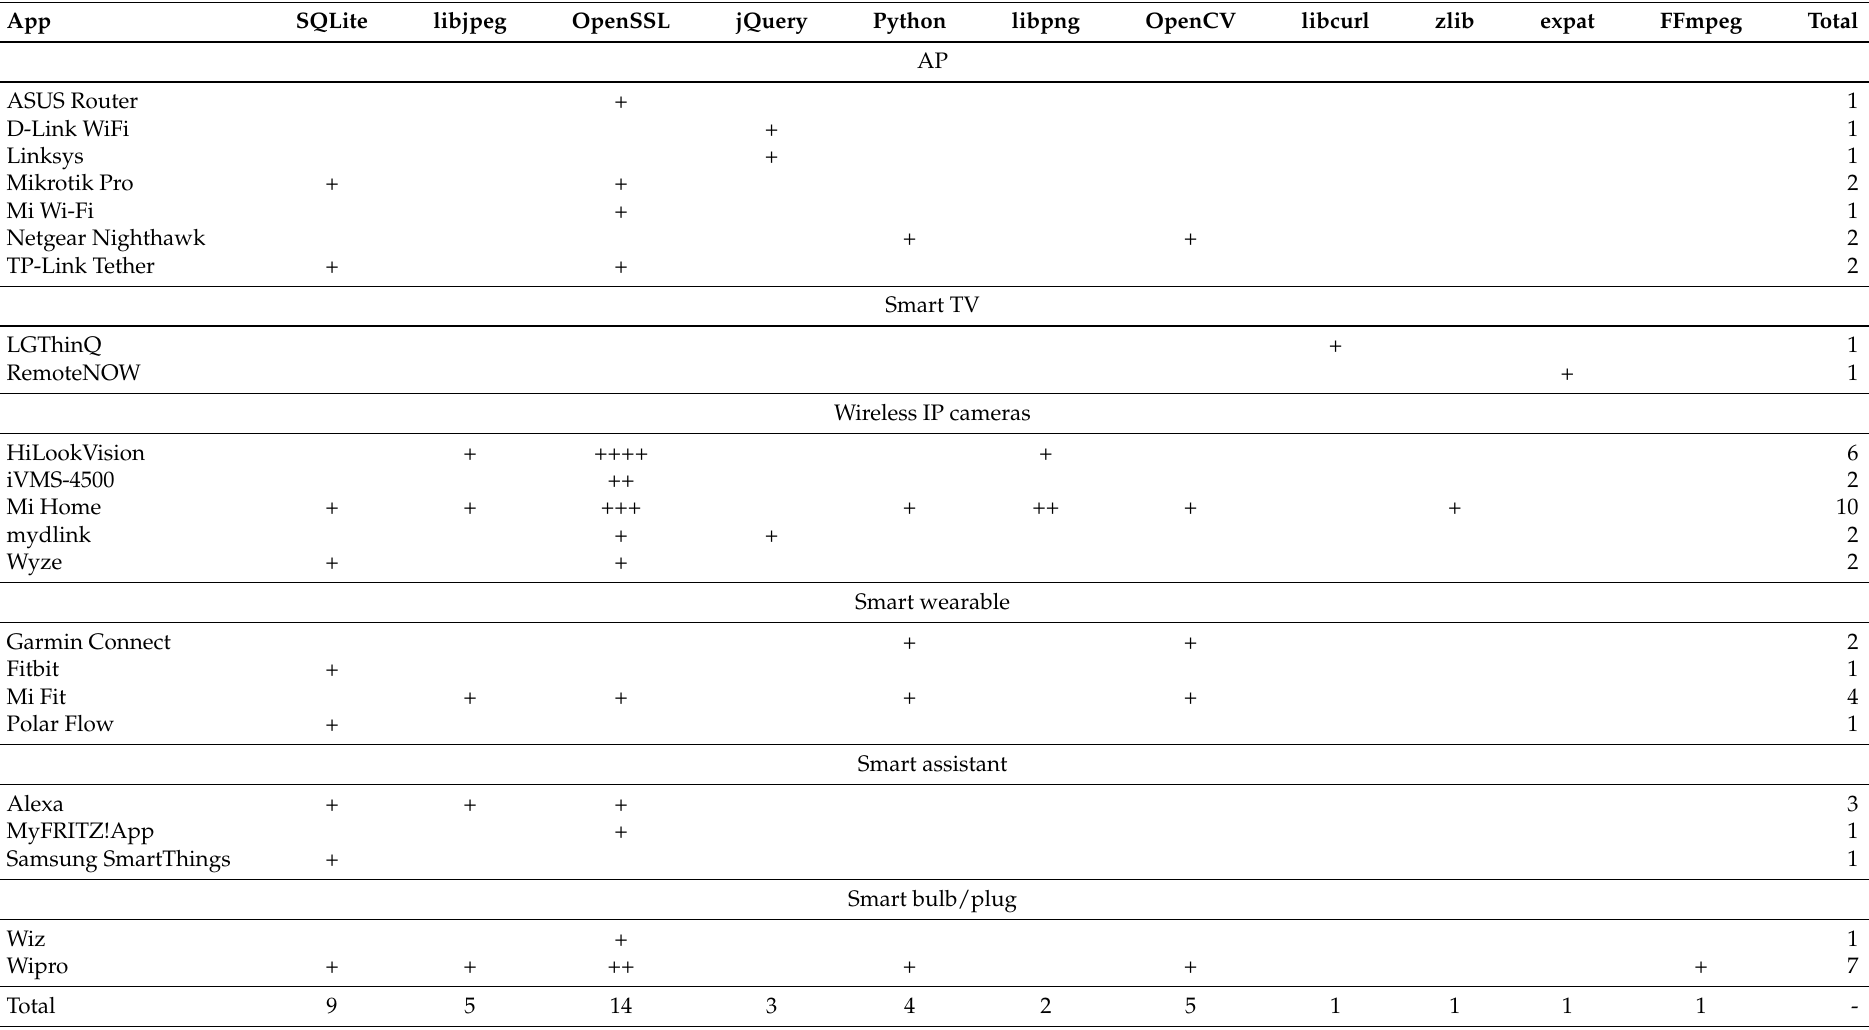
Table 5. Outdated third-party software components per app. The greater the number of “+” signs, the more the number of obsolete components in this